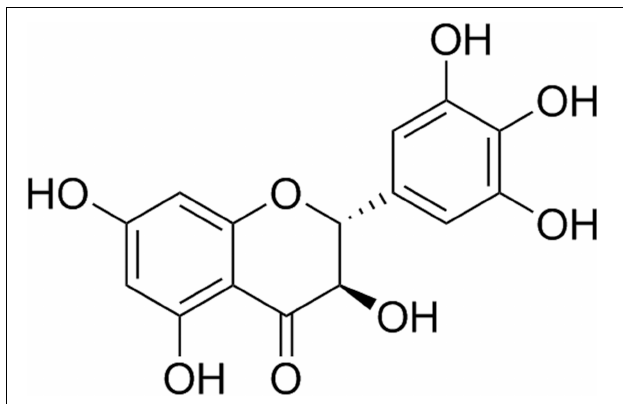
FIGURE 1 | Chemical structure of dihydromyricetin